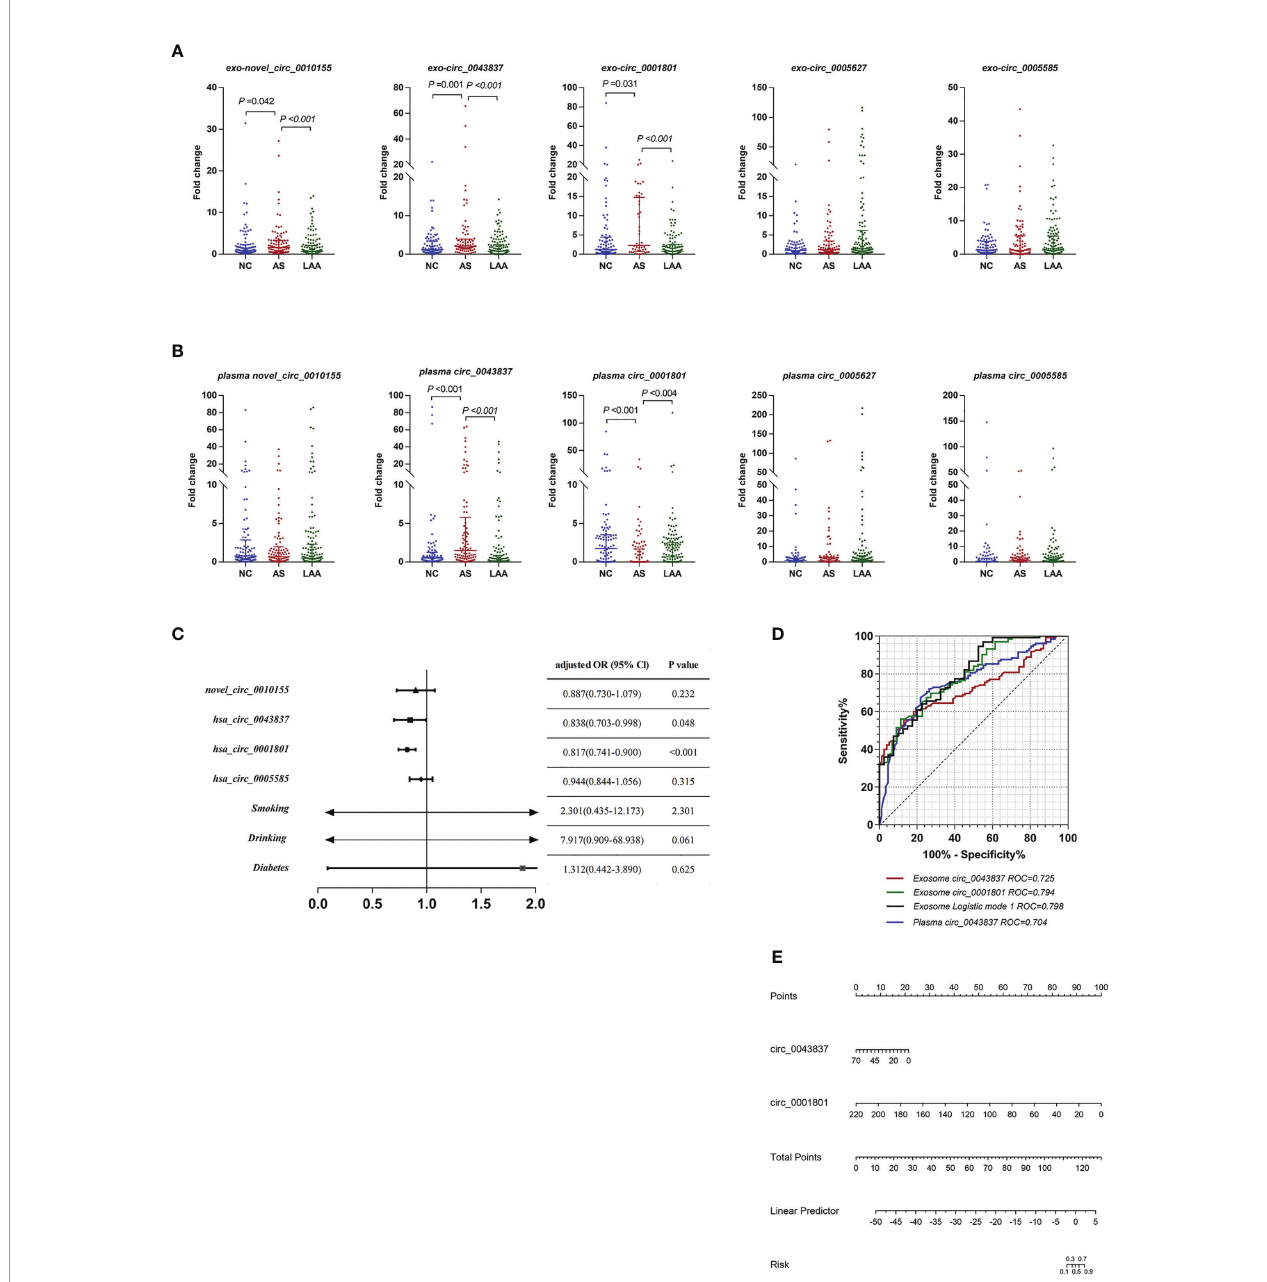
FIGURE 4 | Diagnostic ef fi cacy of plaque rupture of exosomal and plasma circRNAs. (A) Replication of exosomal circRNAs between NC, AS, and LAA group. (B) Replication of plasma circRNAs between NC, AS, and LAA group. (C) Multivariate logistic regression analysis for exosomal circRNAs and clinical. (D) ROC curves of the exosomal circ_0043837, circ_0001801, plasma circ_0043837, and logistic mode 1: Two-exo-circRNA of circ_0043837 and circ_0001801. (E) Nomograms to predict risk of plaque